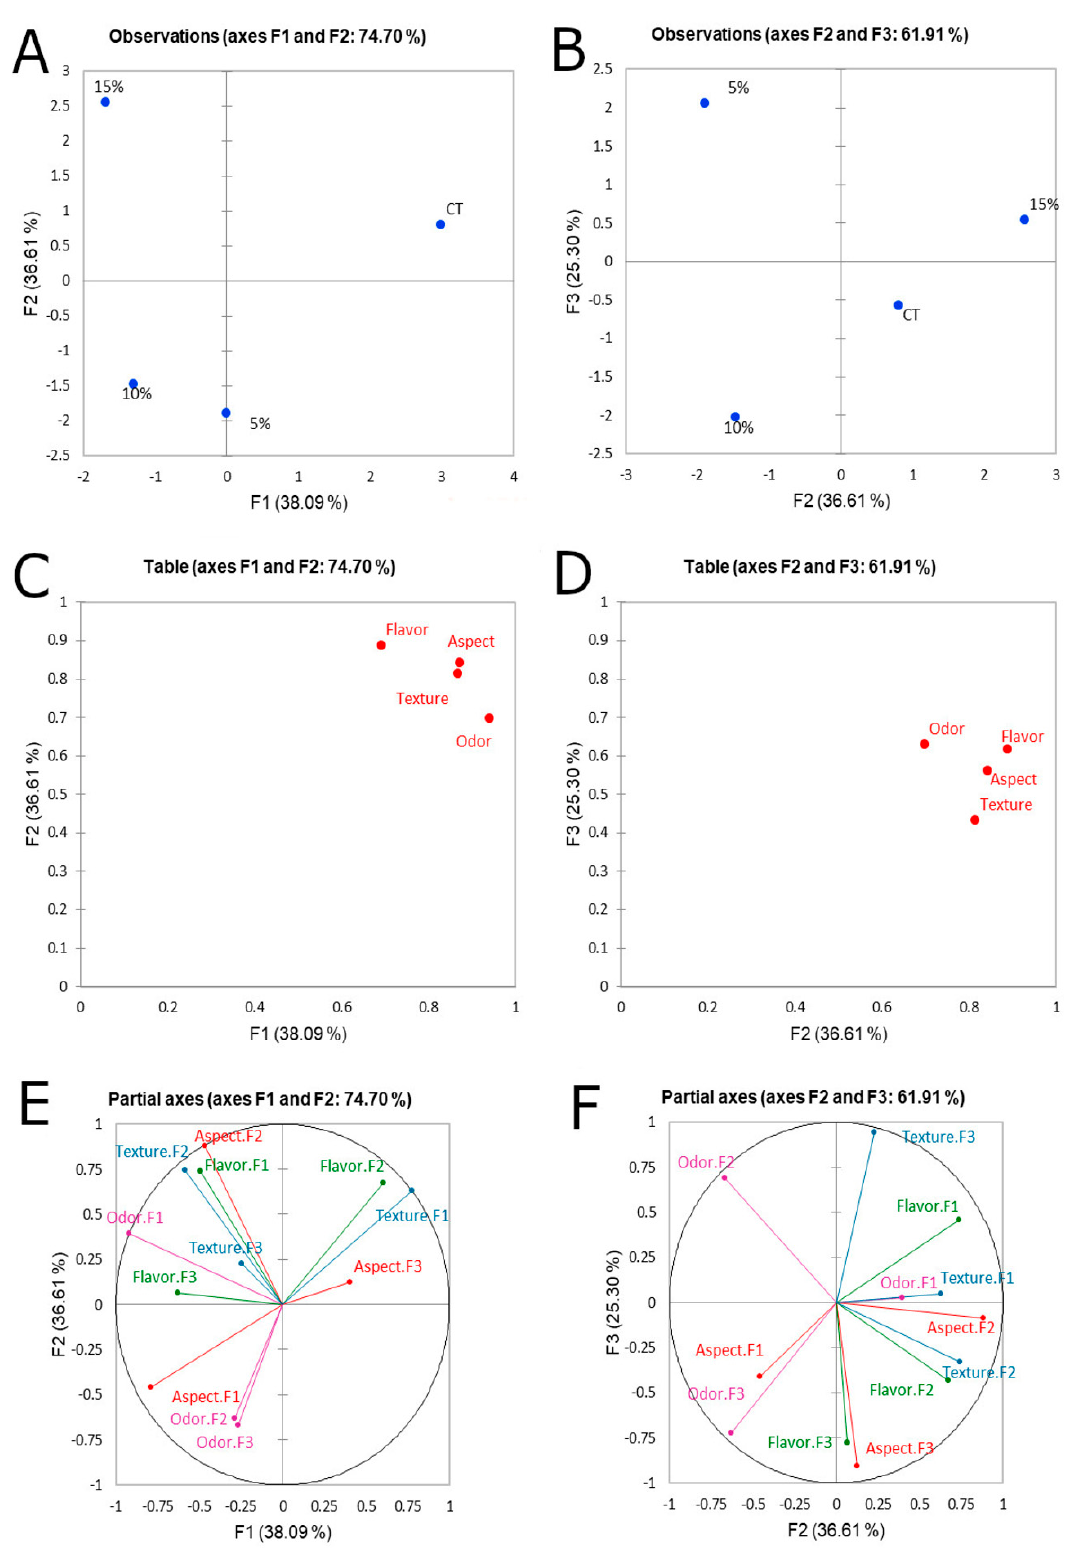
Figure 3. Multifactorial analysis (PCA) on the muffin sensory attributes grouped in odor, taste, texture and appearance. M 5% , muffin containing 5% (wt/wt) type-I sourdough; M 10% , muffin containing 10% (wt/wt) type-I sourdough; M 15% , muffin containing 15% (wt/wt) type-I sourdough; M CT , muffin made without type-I sourdough. ( A , C ), score plots of PC1 vs PC2; ( B , D ) score plots of PC2 vs PC3; ( E ) loading plot of PC1 vs PC2; ( F ), loading plot of PC2 vs PC3.